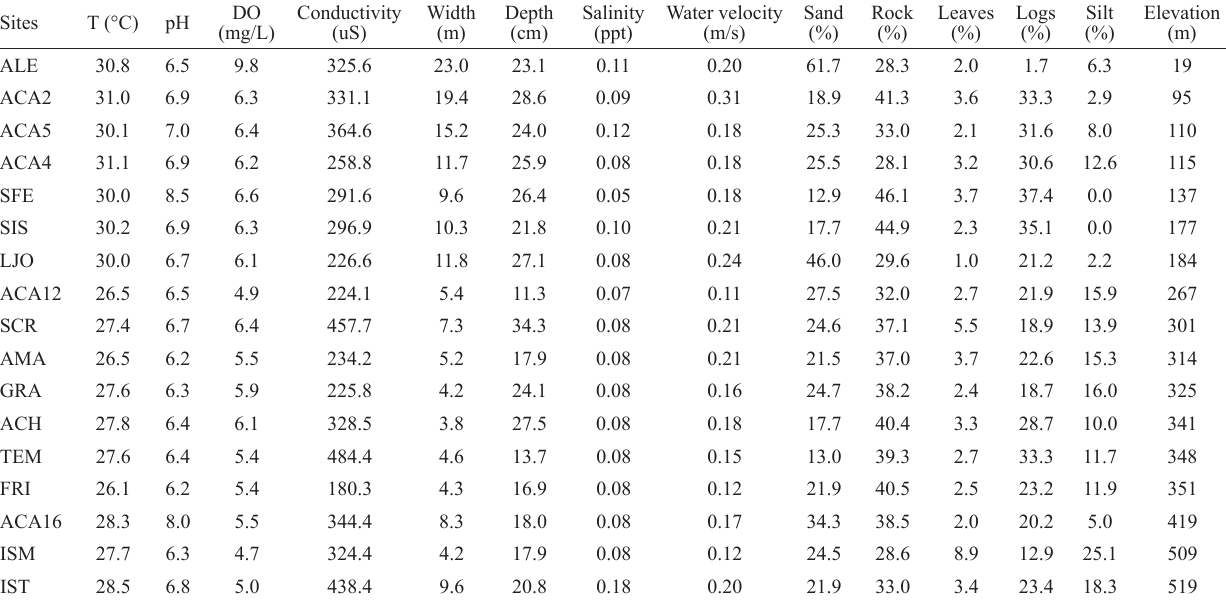
Tab 1. Habitat characteristics of the 17 study sites in the Río Acahuapa, San Vicente, El Salvador, 2011-2012. Average values of each of the environmental variables for five sampling